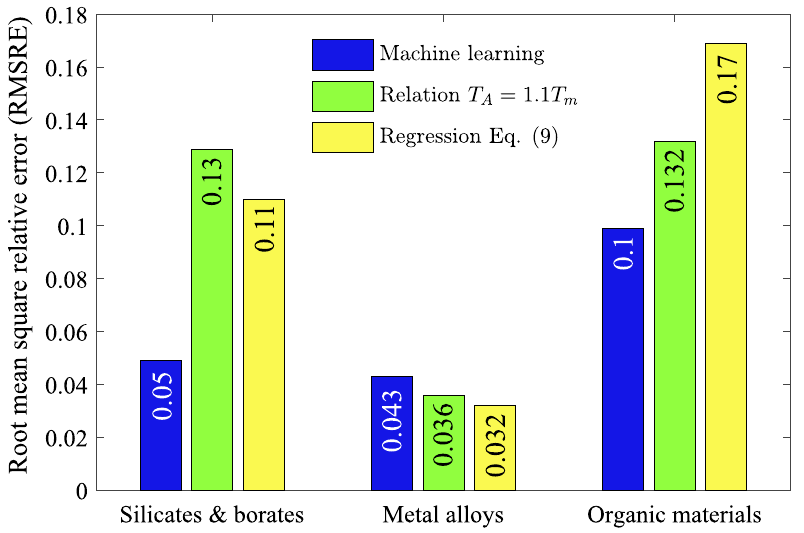
Figure 5. Root mean square relative error between the empirical values of T A and actual T A , which is computed by different methods for silicates, borates, metallic systems and organic